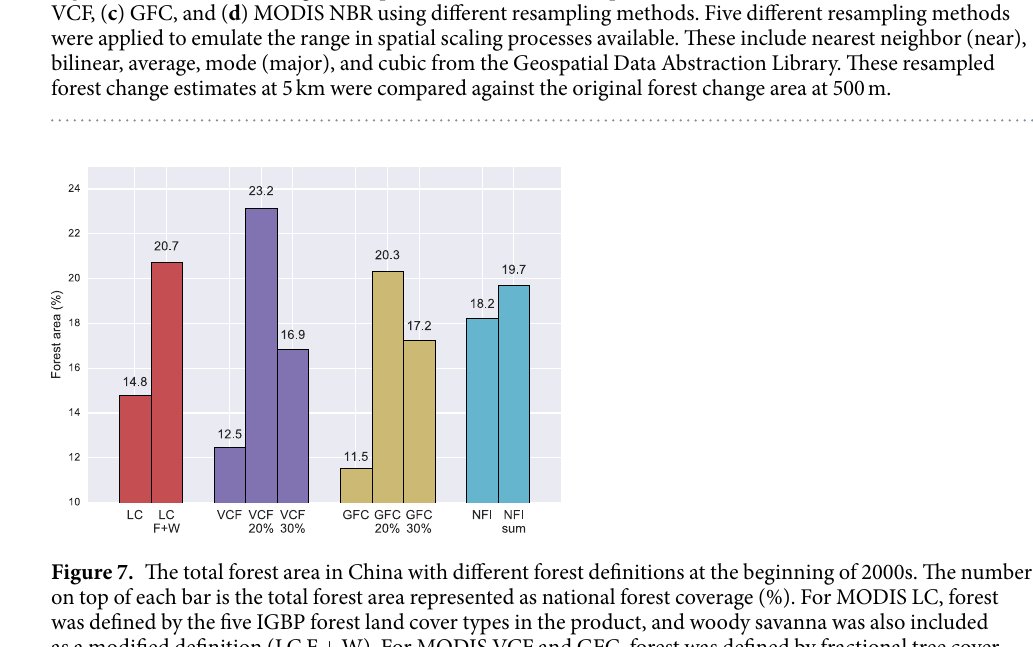
(Fig. 5). Although the datasets had better agreement in estimates of forest loss, the total magnitude of this change was much smaller on average and was not enough to compensate the substantial variance in the estimates of forest gain. The lack of consistency among forest gain estimates could reflect the fact that forest growth is a more